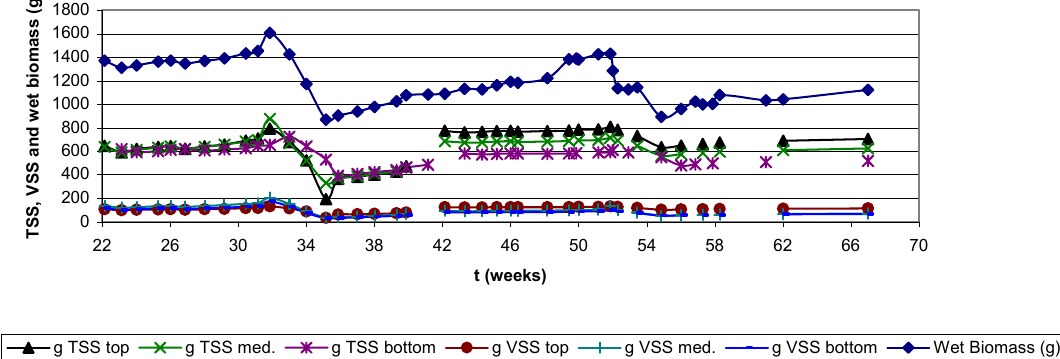
Figure 15. Wet biomass, VSS and TSS (both dry) at upper, medium and bottom biofilter